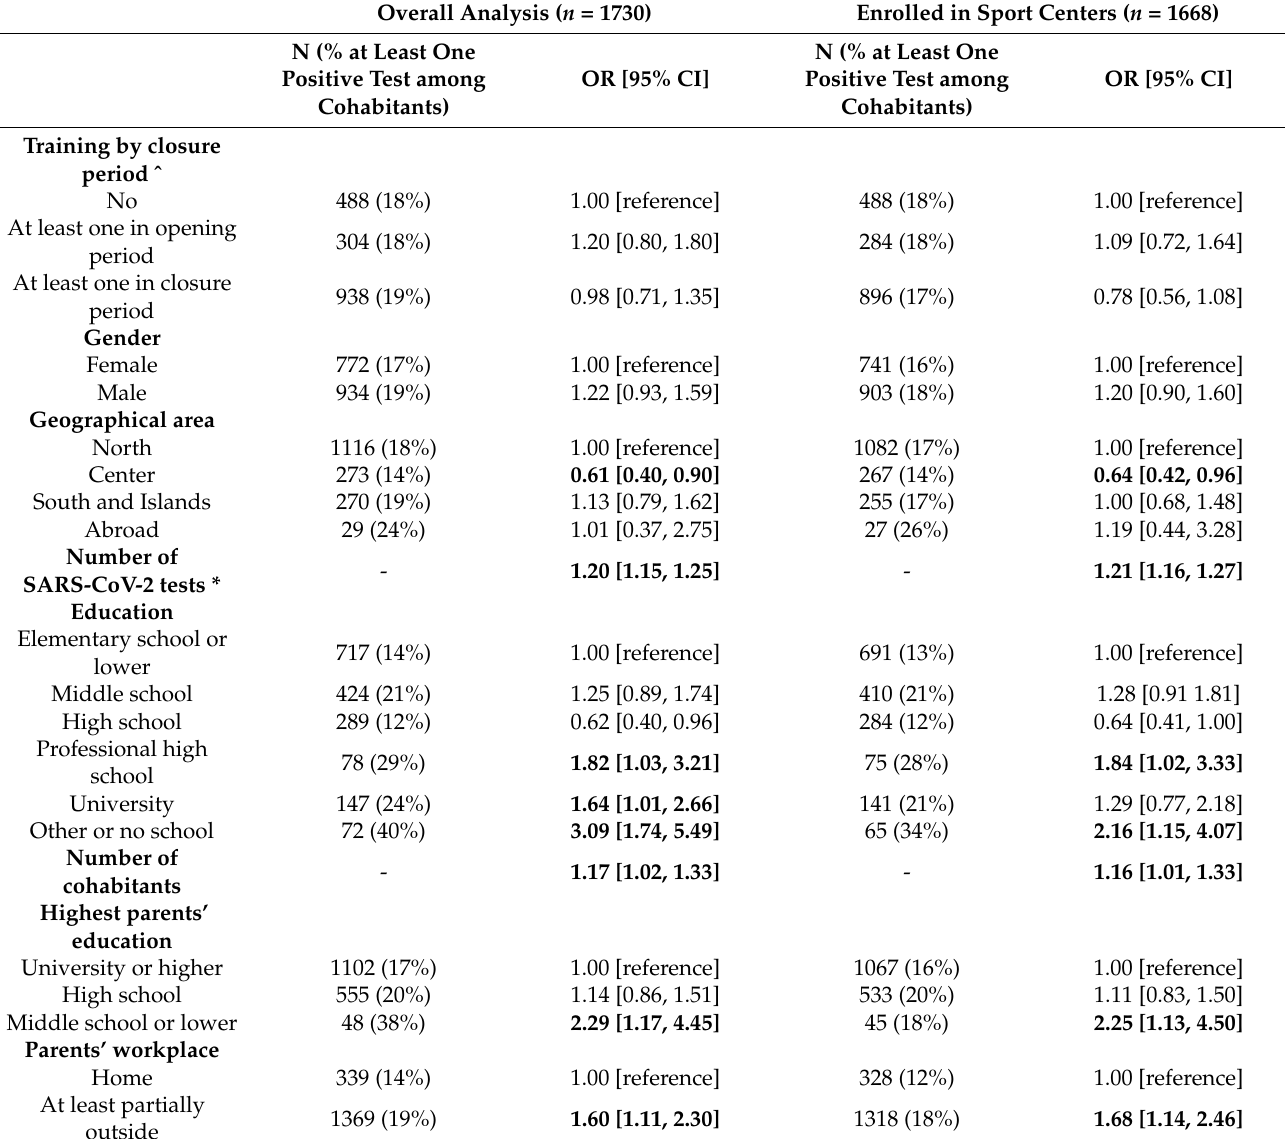
Table 3. Multivariable analysis for the risk of at least one person among cohabitants tested positive for SARS-CoV-2 in the overall study population and in the subgroup of athletes enrolled in sports centers. Analysis comparing families of athletes with training sessions in opening and closing